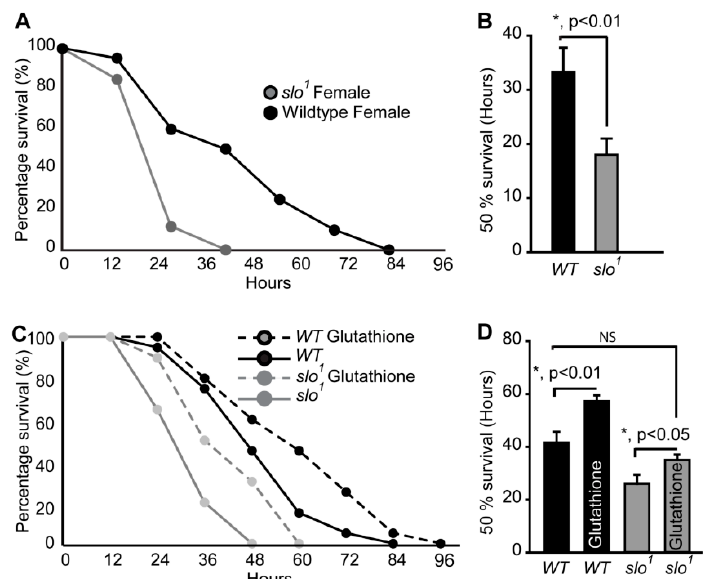
Figure 3. Oxidative stress on fly survival. ( A ) Survival of slo 1 mutants is significantly lower compared to wt flies fed on 20 mM PQ in 5% ( w / v ) sucrose. ( B ) Histogram shows 50% survival for and slo 1 and wt flies. ( C ) Survival of slo 1 mutants while PQ feeding with or without glutathione. ( D ) Histogram shows 50% survival for and slo 1 mutants with or without reduced glutathione (GSH). GSH increased the survival of wild-type and slo 1 mutants.